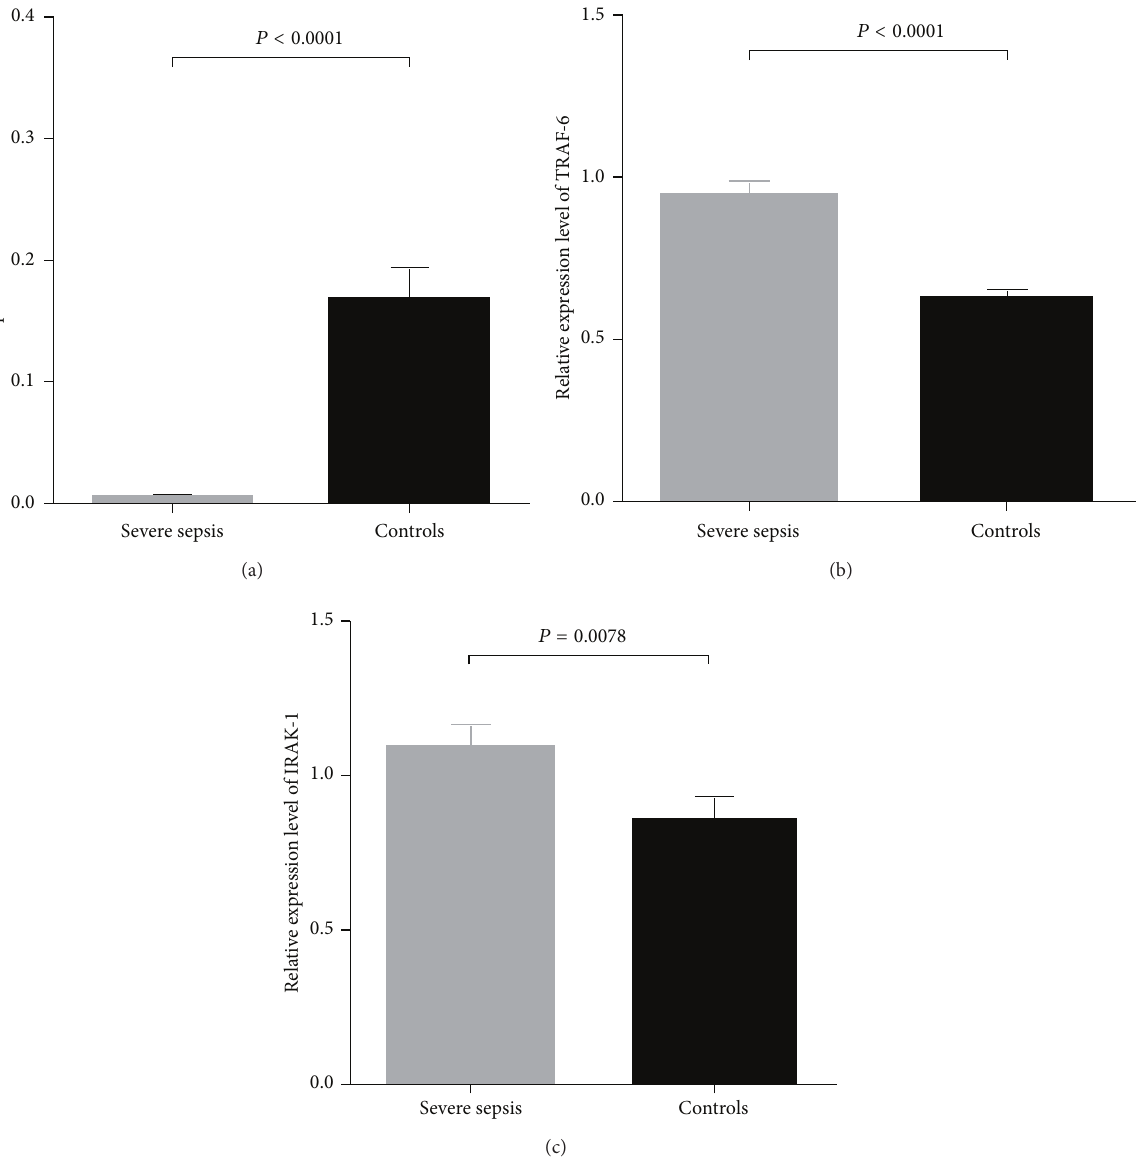
Figure 1: Expression levels of miR-146a (a), TRAF-6 (b), and IRAK-1 (c) in severe sepsis patients ( 𝑛 = 37 ) and normal controls ( 𝑛 = 40 ),